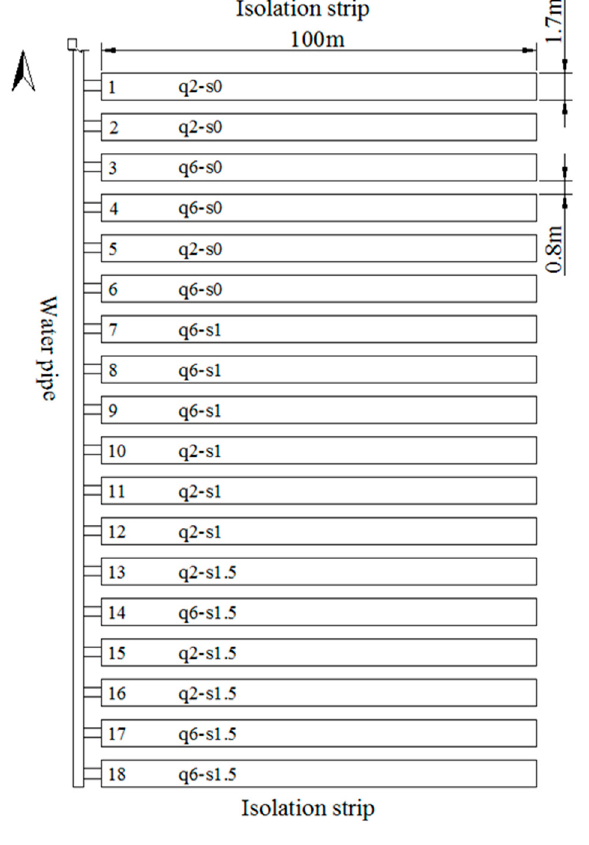
Figure 3. Farmland layout.